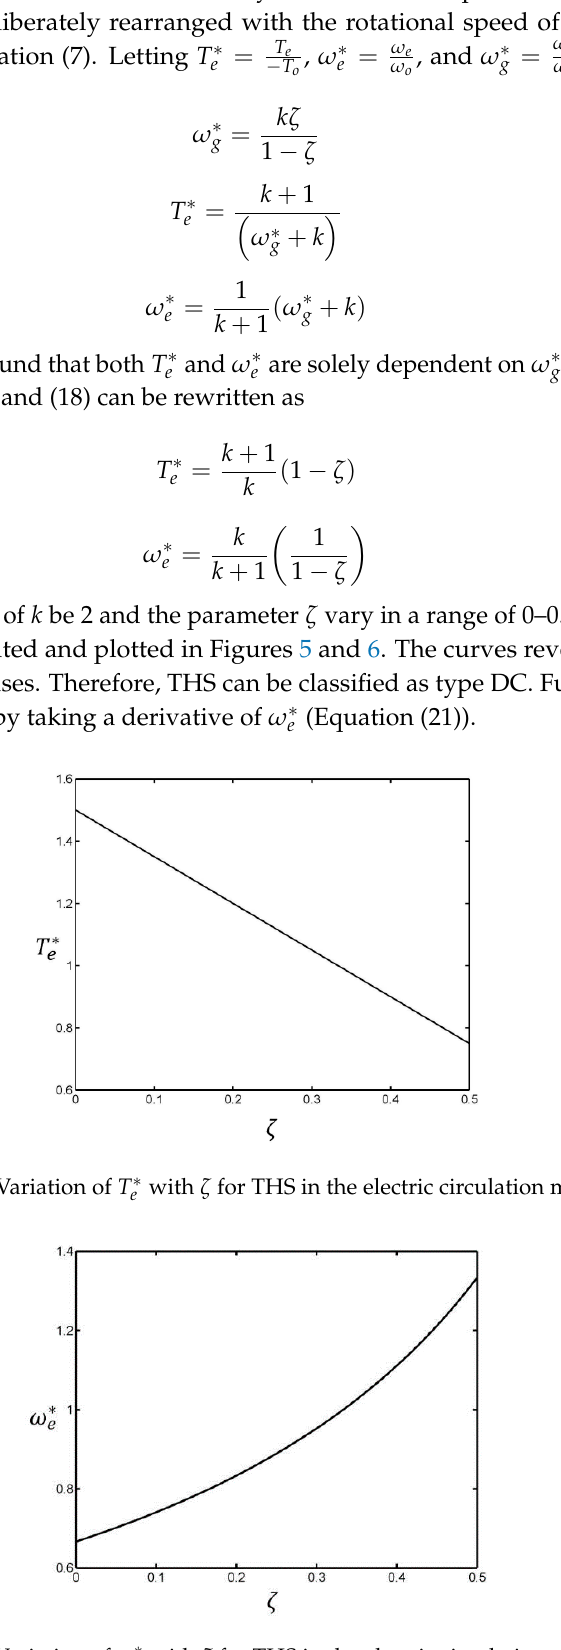
Figure 6. Variation of (cid:2033) (cid:3032)∗ with (cid:2014) for THS in the electric circulation mode.